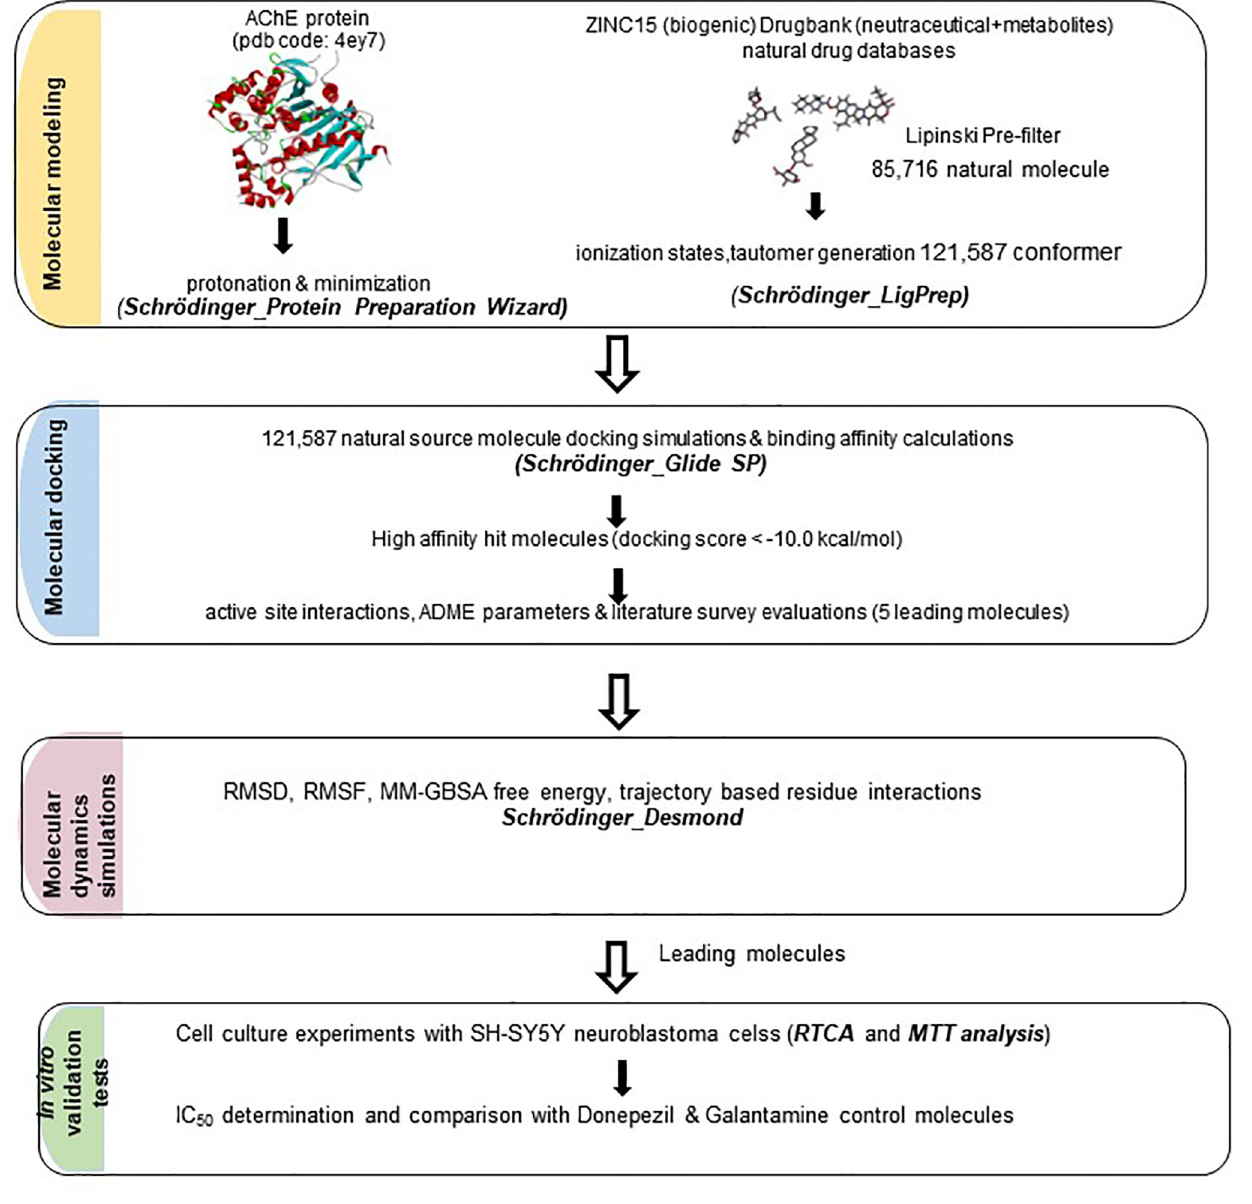
Fig 8. Schematic representation of the